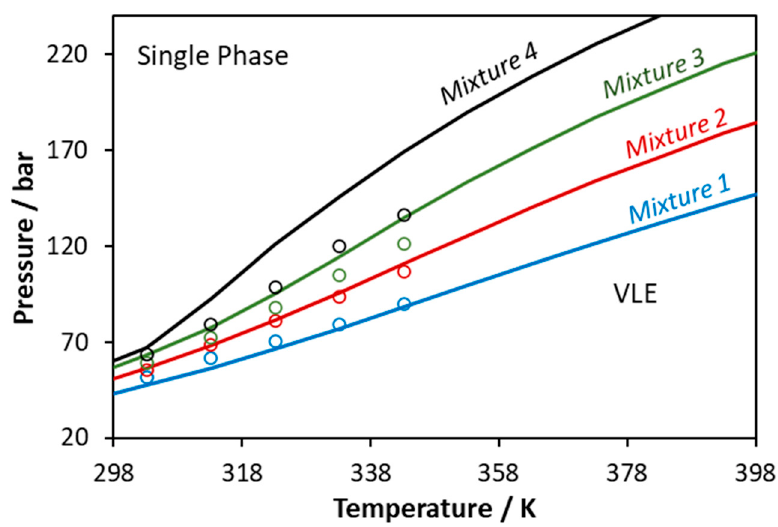
Figure 9. Phase boundaries for CO 2 –glycerol–methanol ternary system. Experimental data (points, [55]) and CPA predictions using the binary interaction parameters of Table 6 (Mixture 1: x CO2 = 0.3373, x glycerol = 0.0212, x methanol = 0.6415; Mixture 2: x CO2 = 0.4352, x glycerol = 0.0180, x methanol = 0.5468; Mix- ture 3: x CO2 = 0.5359, x glycerol = 0.0148, x methanol = 0.4493; Mixture 4: x CO2 = 0.6430, x glycerol = 0.0114, x methanol = 0.3456).